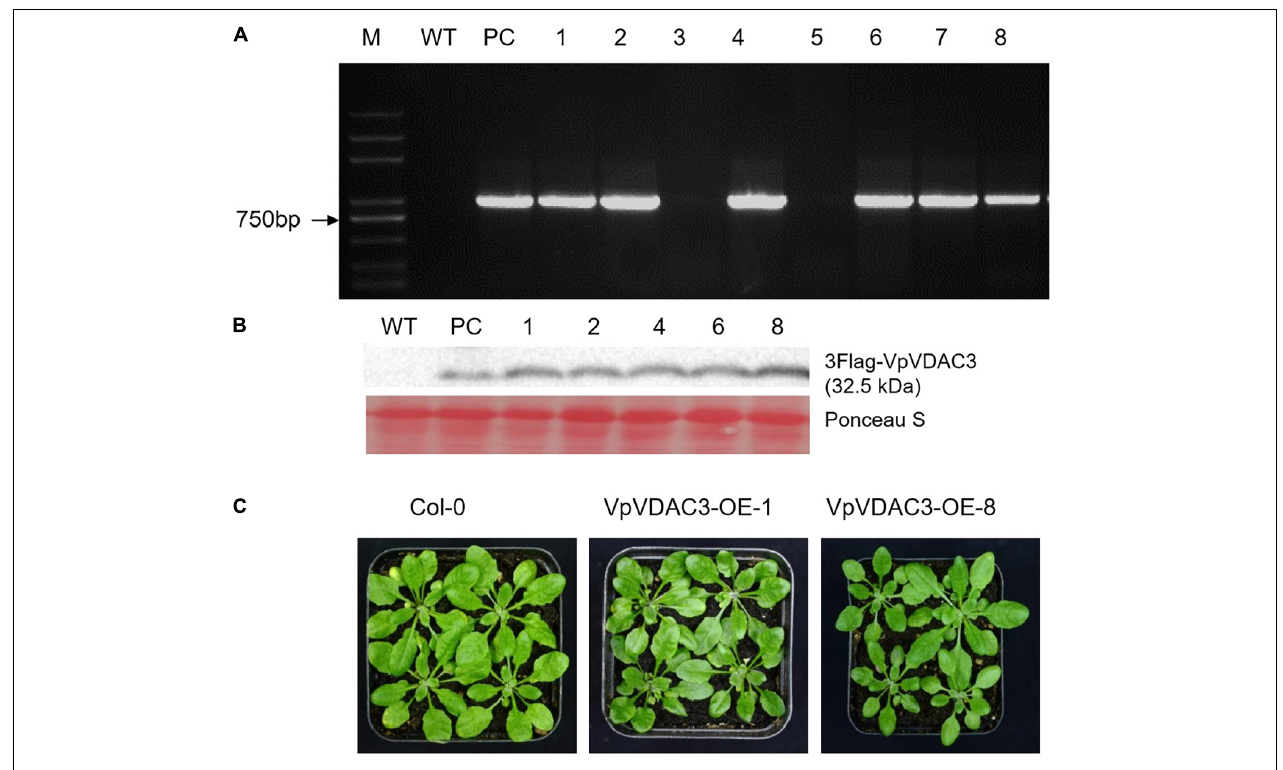
FIGURE 7 | Morphology and VpVDAC3 expression in transgenic Arabidopsis lines. (A) RT-qPCR detection of VpVDAC3 in two independent stable transgenic p35S:VpVDAC3 Arabidopsis lines. (B) Immunoblot detection of VpVDAC3 proteins expressed in stable transgenic lines. (C) Morphology of WT (Col-0) and two independent transgenic Arabidopsis lines grown under normal conditions. M, marker; WT, wild-type Col-0; PC, positive